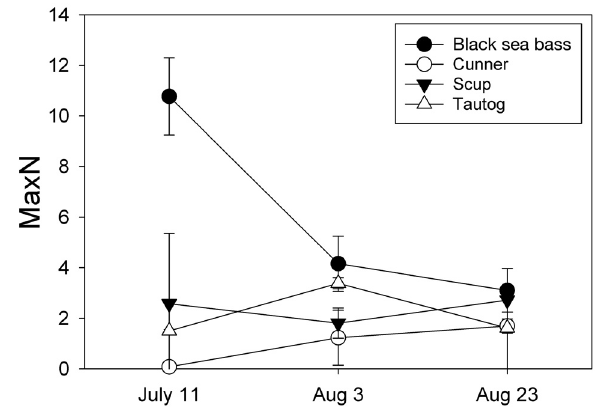
Fig. 3. Abundance of the 4 most commonly observed fish as- sociated with oyster aquaculture cages over 3 dates where interval recording was conducted. The daily average MaxN was calculated for each cage (where MaxN was defined as the maximum number of fish of a given species present in a single frame for each 8 min recording segment). Symbols and error bars represent the mean ±